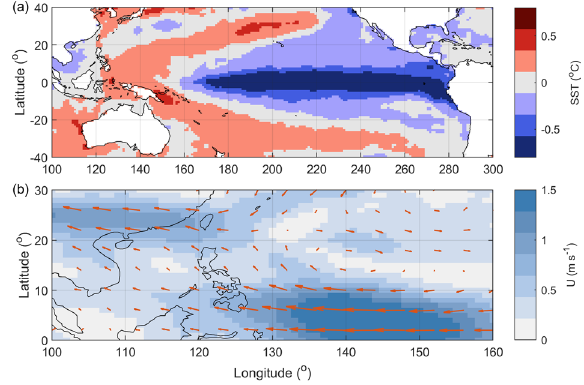
Fig. 3 Tropical Paci fi c anomalies associated with increased South China landfall. May – November anomalies of a sea surface temperature, and b wind at 500 hPa. Anomalies calculated as difference between mean lower and upper subNiño4 JJA-1 tercile years. Lower and upper tercile thresholds are – 0.15 and 0.30 ∘ C, respectively. Magnitude of wind vector anomaly is shaded, arrows show